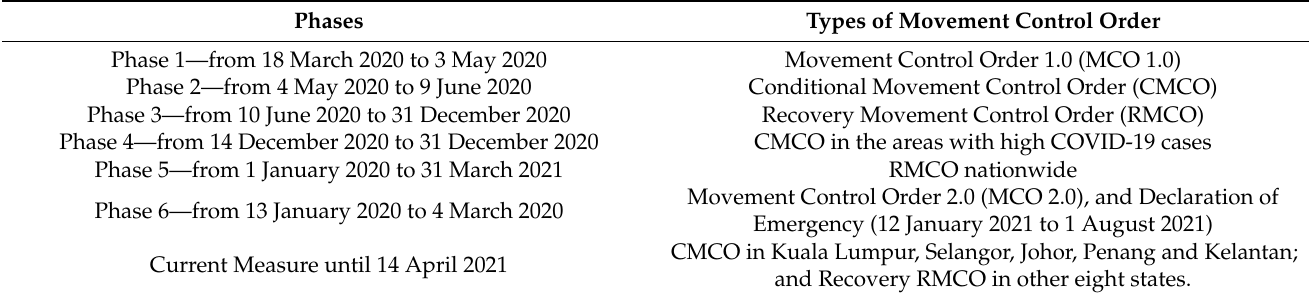
Table 2. Phases of movement control orders in Malaysia during the COVID-19 period, derived from [59].